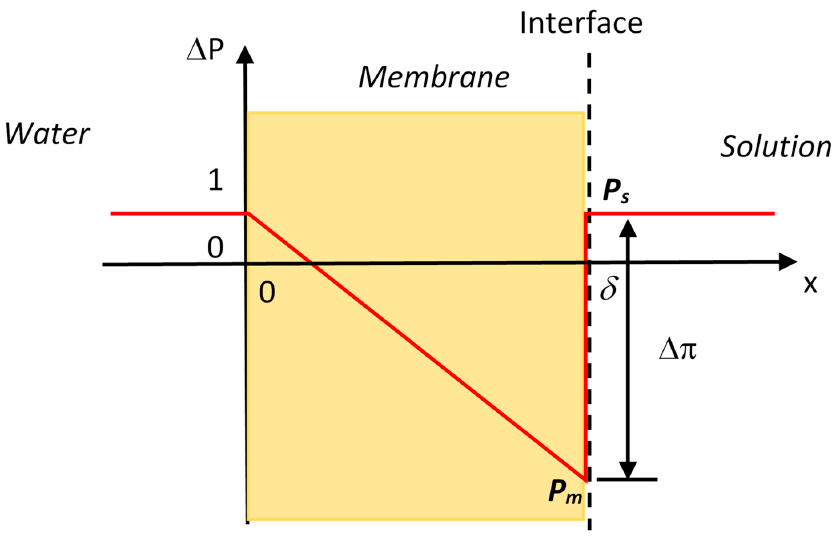
Figure 1. Hydraulic pressure profile along the membrane thickness induced by the osmotic pressure. Negative hydraulic pressure occurs inside of the membrane.